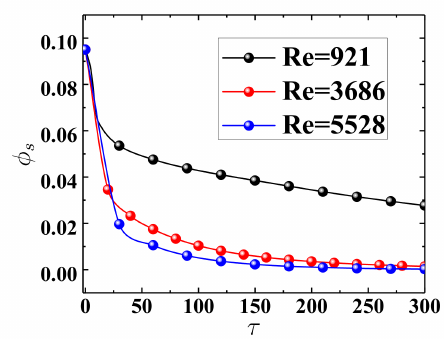
Figure 11. Nanoparticle accumulation ( φ s ) as a function of time for different Reynolds numbers.